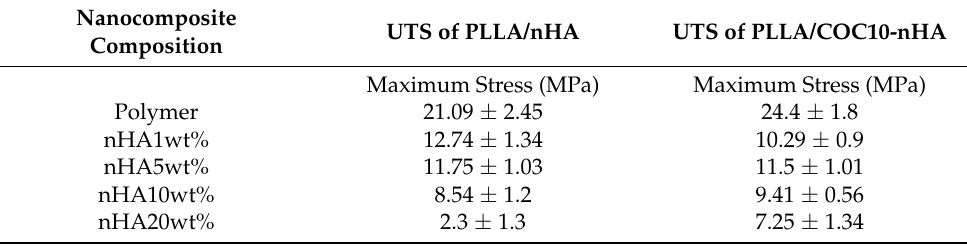
Table 4. Presenting the maximum stress of PLLA/COC/10-nHA and PLLA/nHA